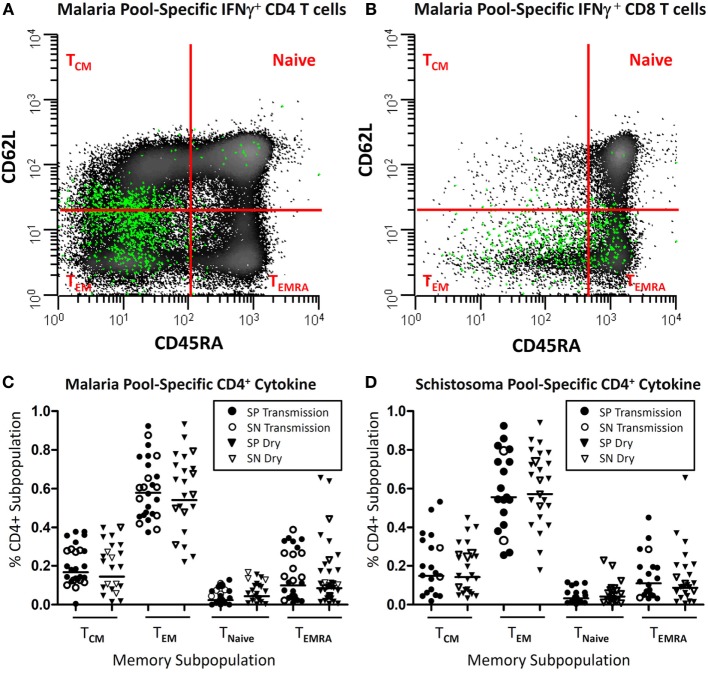
Parasite-specific memory subpopulations. Depicted is a representative example (A,B) of where T cells expressing intracellular IFN-γ (green) after antigen stimulation (malaria pool consisting of apical membrane antigen 1 and merozoite surface protein 1) distribute after being back gated onto the total population CD3+CD19−CD14− cells following live/dead discrimination and stratified as CD4+
(A) or CD8+
(B) from a child with acute Plasmodium falciparum infection and further stratified by memory subpopulation utilizing CD45RA and CD62L surface markers. Panels (C,D) depict the distribution of cytokine-secreting (either IFN-γ, TNF-α, IL2, and/or IL17A), malaria or schistosoma-specific CD4+ T cells, stratified by memory subpopulation, in children with (SP) or without Schistosoma haematobium (SN), during the transmission season and at a later convalescent time point (dry season).